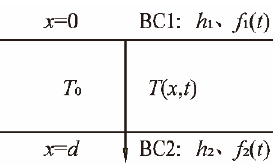
Figure 7. One-dimensional model of the temperature distribution.